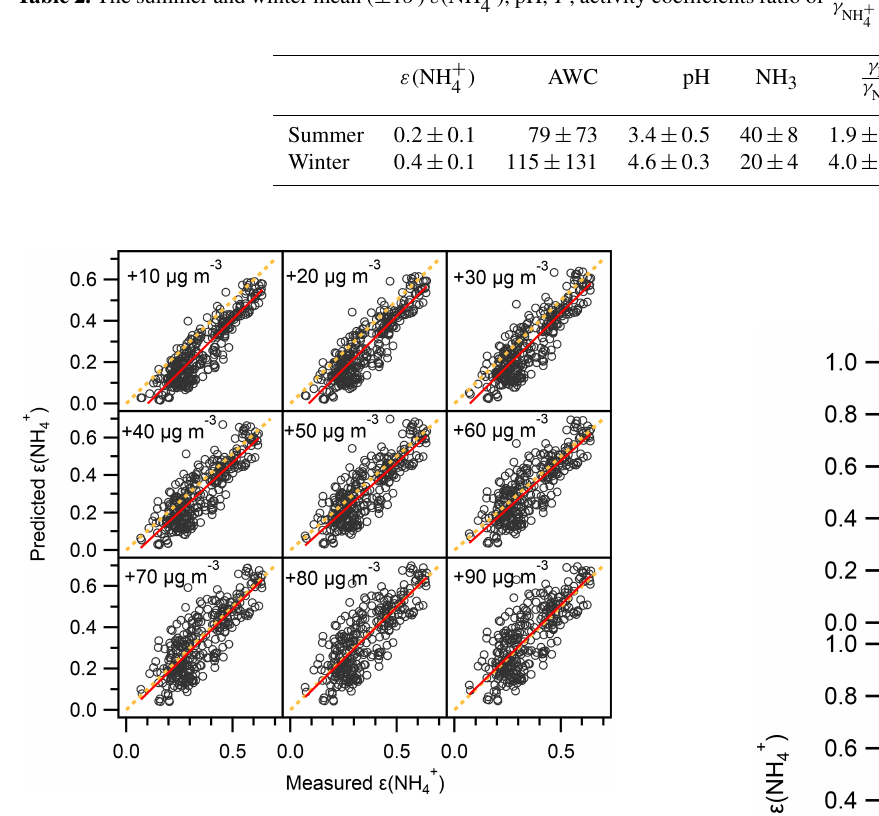
Table 2. The summer and winter mean ( ± 1 σ ) ε (NH +